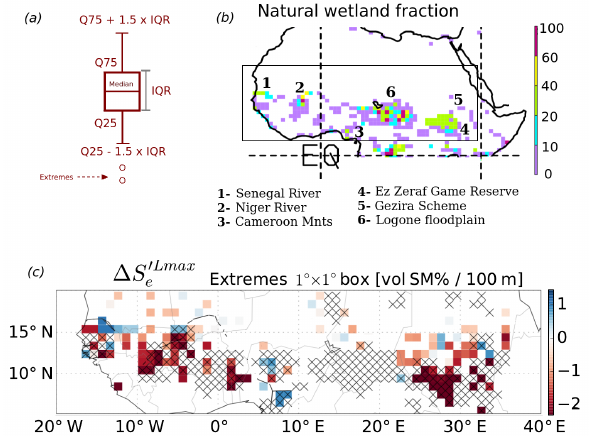
(Fig. 6b, c). Regional distribution of extreme (cid:49)(S (cid:48) L max e )